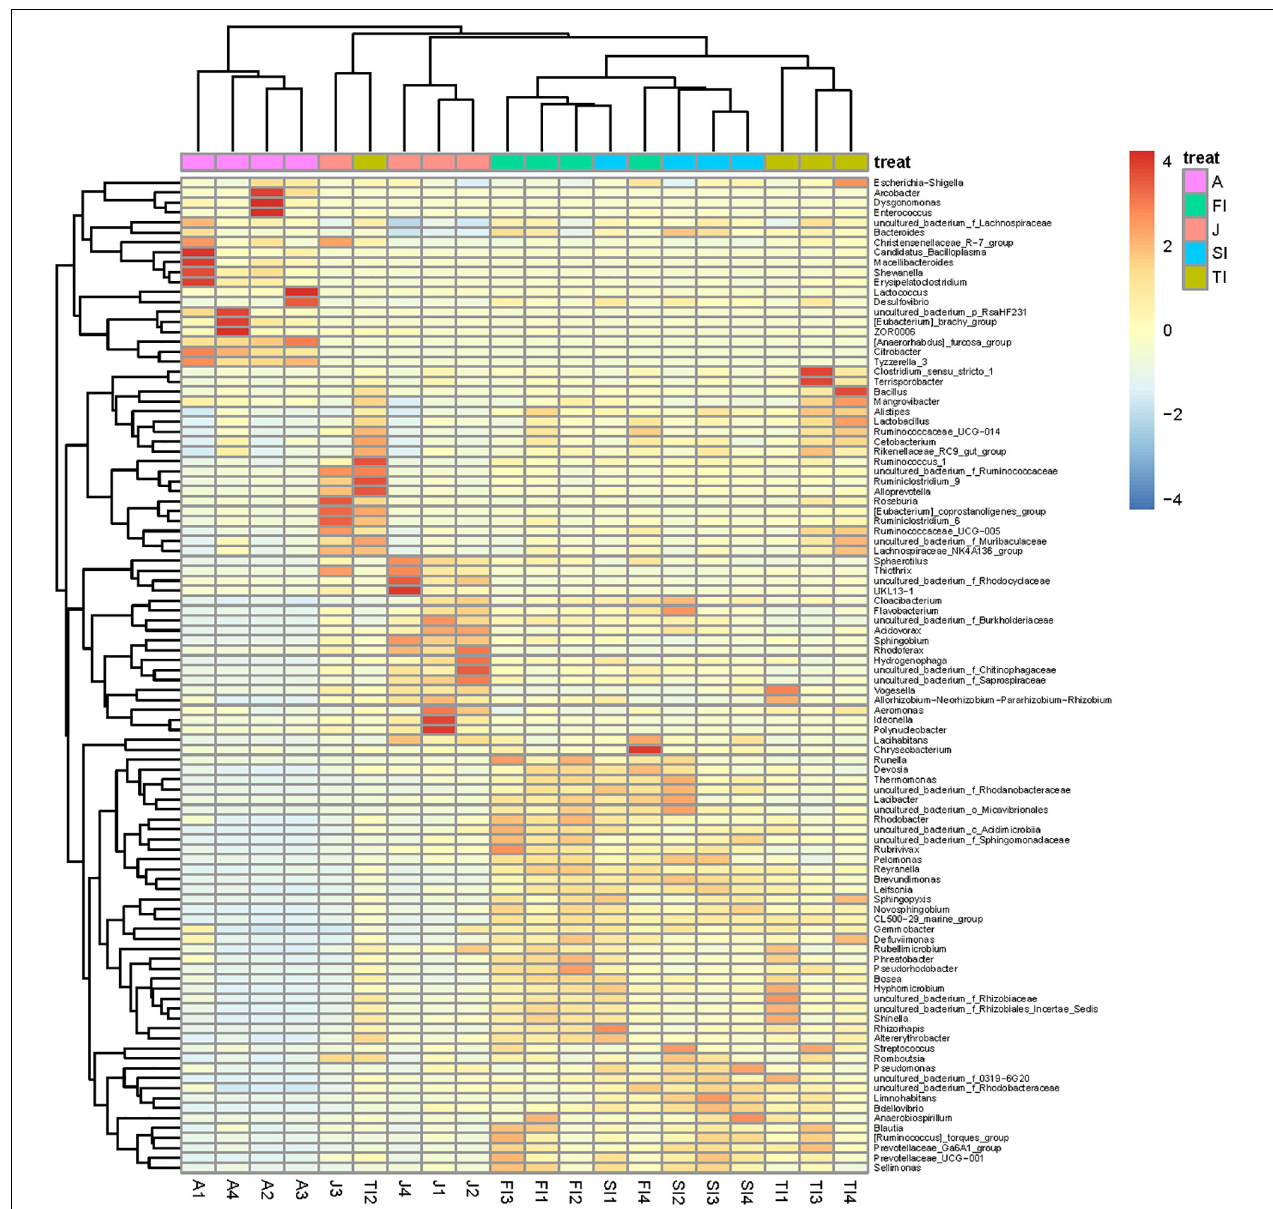
FIGURE 4 | Heatmap analysis of the bacterial species in all samples. The color of the bar represents the relative abundance of each bacterial genus in all samples. The longitudinal clustering indicates the similarity of all species among different samples.